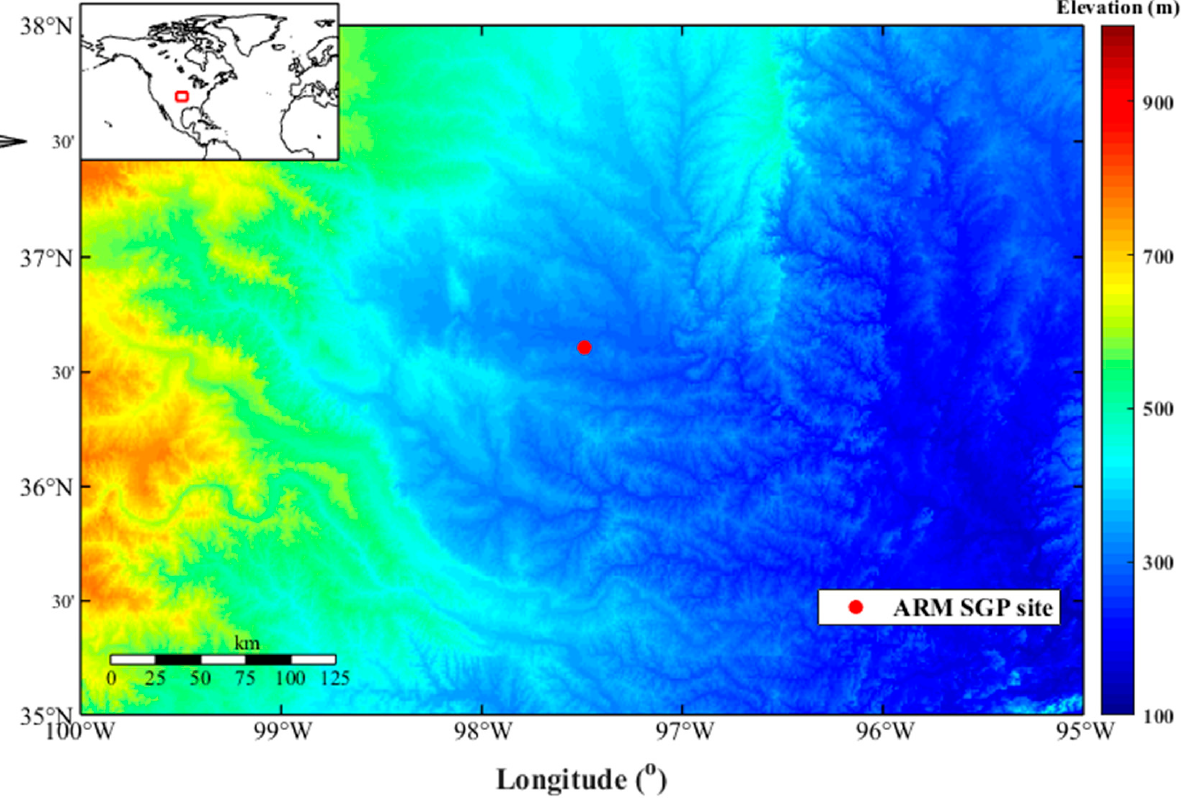
Figure 1. SGP station of the ARM